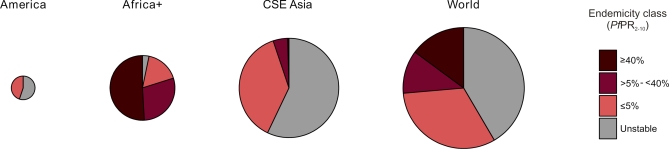
Pie Charts Showing the PAR of P. falciparum Malaria in 2007The charts show the proportion of the population living in each predicted PfPR2−10 endemicity classes for the America, Africa+, CSE Asia regions, and worldwide. The charts are scaled proportionally to the total population at risk in each region and the segments are coloured to match the endemicity classes shown in Figure 4.